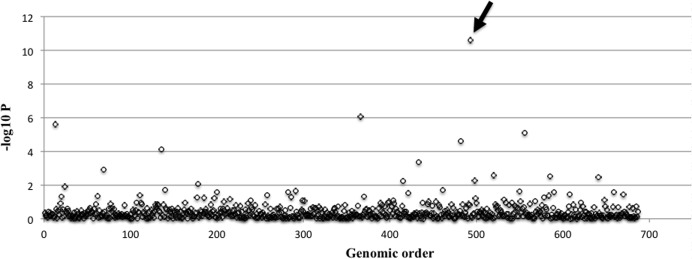
The association findings for age of first phrase (AFP) are presented as –log10 p-values (unadjusted by multiple tests) across the whole autosome.The arrow indicates the ROH region at 11q22.3.